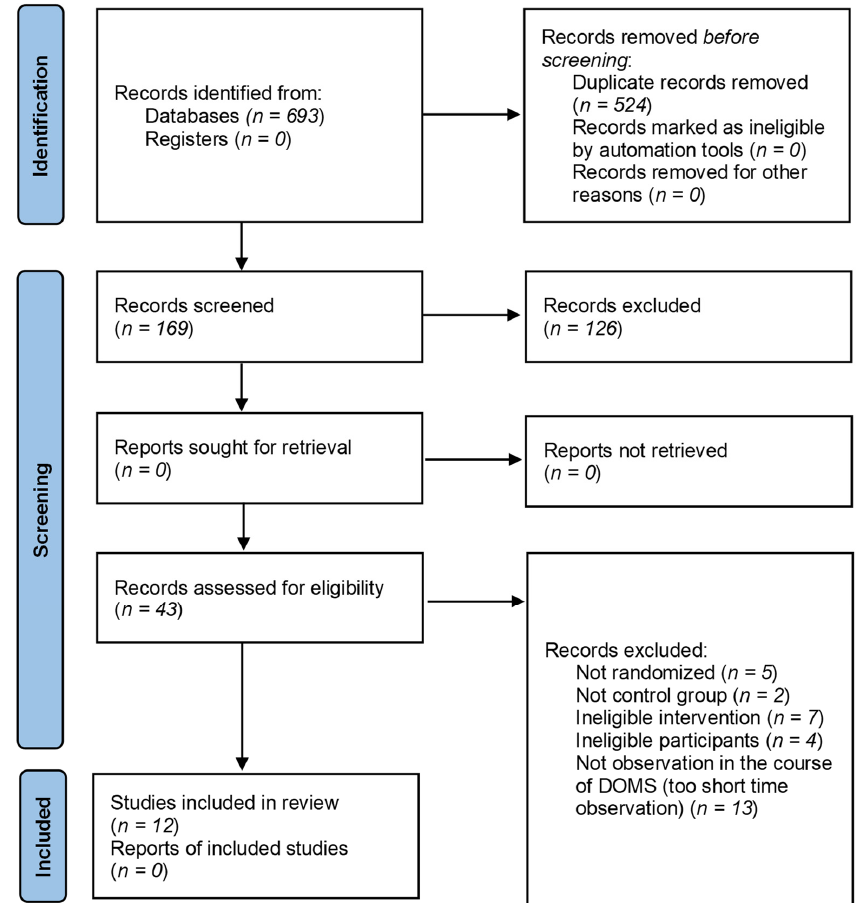
Figure 3. PRISMA flow diagram of included/excluded studies.